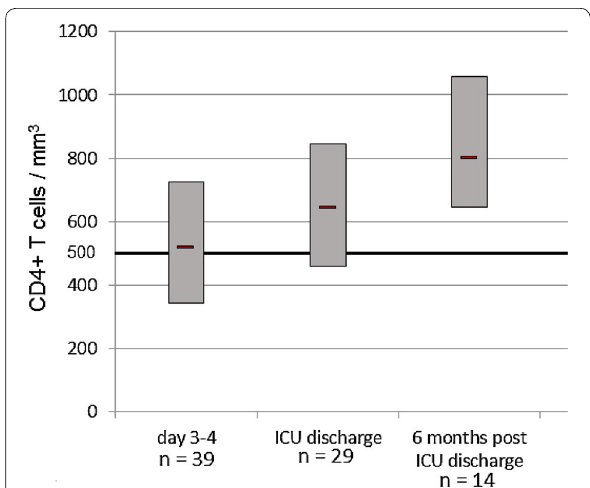
Fig. 3 CD4 T cells from day 3 after ICU admission to 6 months + after ICU discharge. Box plot interpretation: box borders: 1st and 3rd quartile, central band in box: median